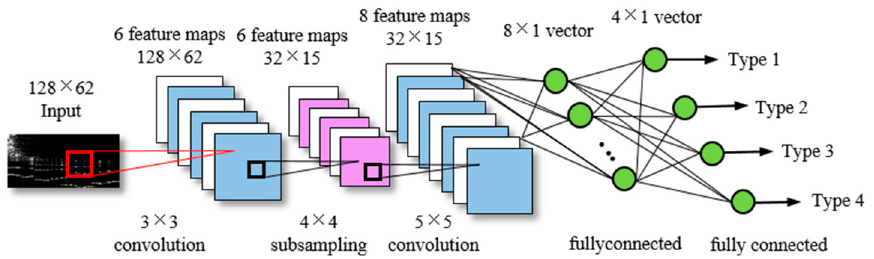
Table 5. Sample numbers of faulty and normal conditions. Types (c) Figure 7. Three types of image samples corresponding to: ( a ) Frequency domain, size 128 × 62 (FD); ( b ) time-frequency domain (TFD), size 256 × 256; and ( c ) three-domains (ThD), size 256 × 265. 5. Implementation and Results The bearing fault diagnosis is performed on three fault types (IR, RE, and OR) and the normal condition (NC). In this process, the ratio of the validation dataset is set to be 0.2. The Deep Network Designer embedded in Matlab is employed for the construction, training, and validation of DCNN using a single CUDA-enabled NVIDIA Quadro P4000 GPU. 5.1. Comparison between DCNN and Ada-DCNN First, the DCNNs corresponding to the three types of samples in Figure 7 are built and denoted as FD-Net, TFD-Net, and ThD-Net, respectively. As an example, the final structure and parameters of the FD-Net is illustrated in Figure 8. Each network is iteratively tuned to specify the structure and hyperparameters such as layer and channel numbers, kernel sizes, and so on. Once the training of